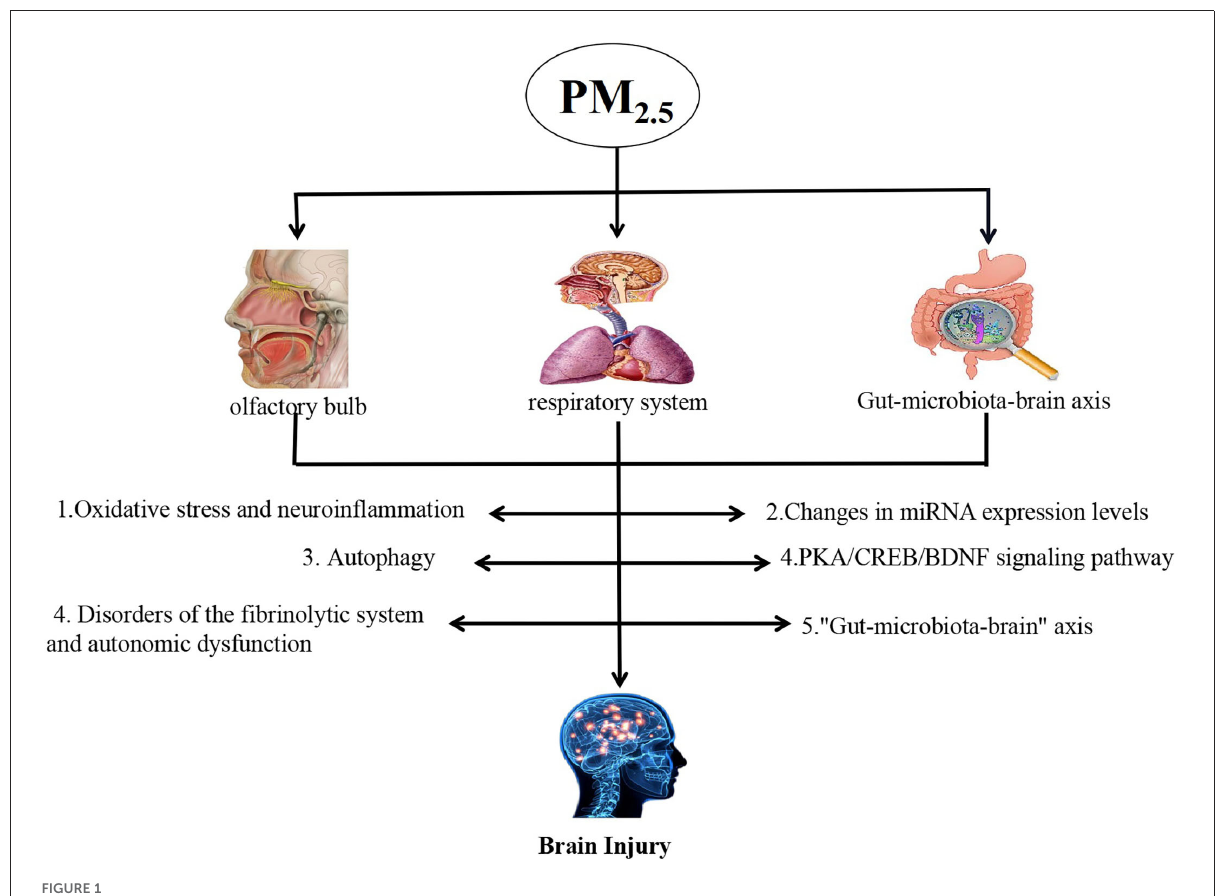
FIGURE1 The pathways involved in PM 2.5 -induced brain